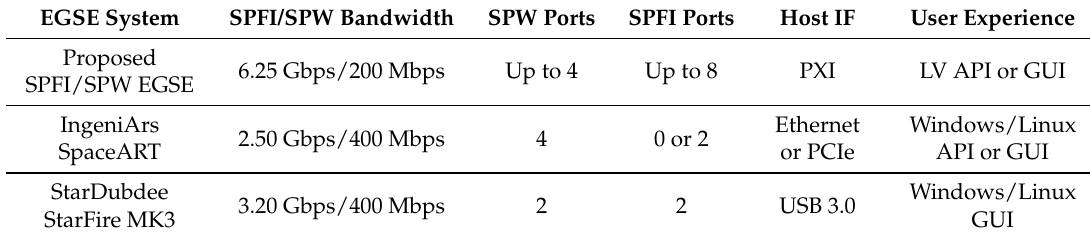
Table 2. Comparison table of the available SpaceFibre EGSE solutions by features: maximum bandwidth per link, number of SPW IFs, number of SPFI IFs, type of remote host IF, type of control user